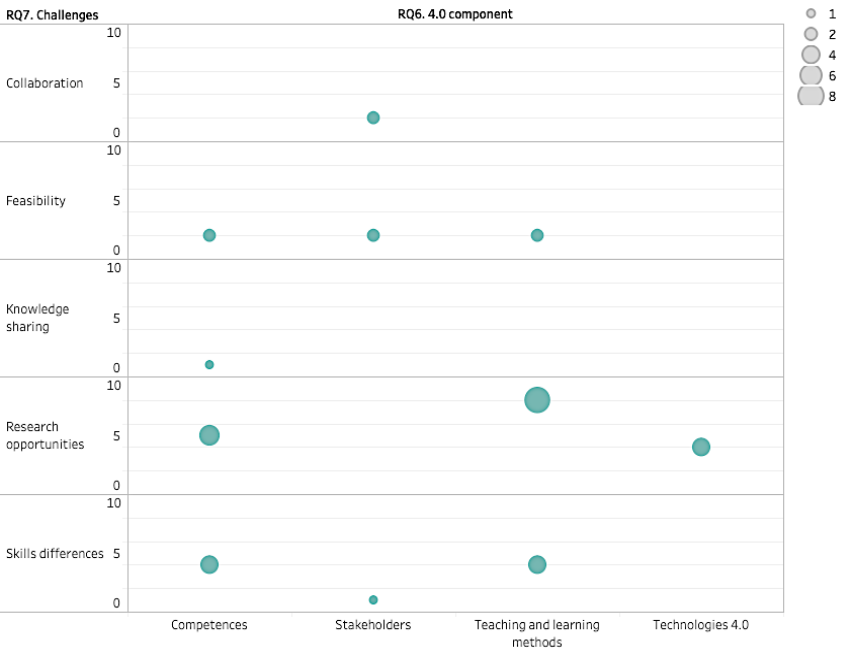
Figure 6. Predominant components and educational research challenges in the